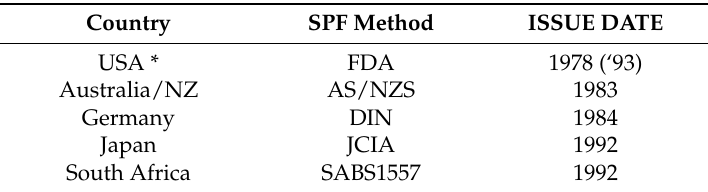
Table 2. SPF assessment methods before